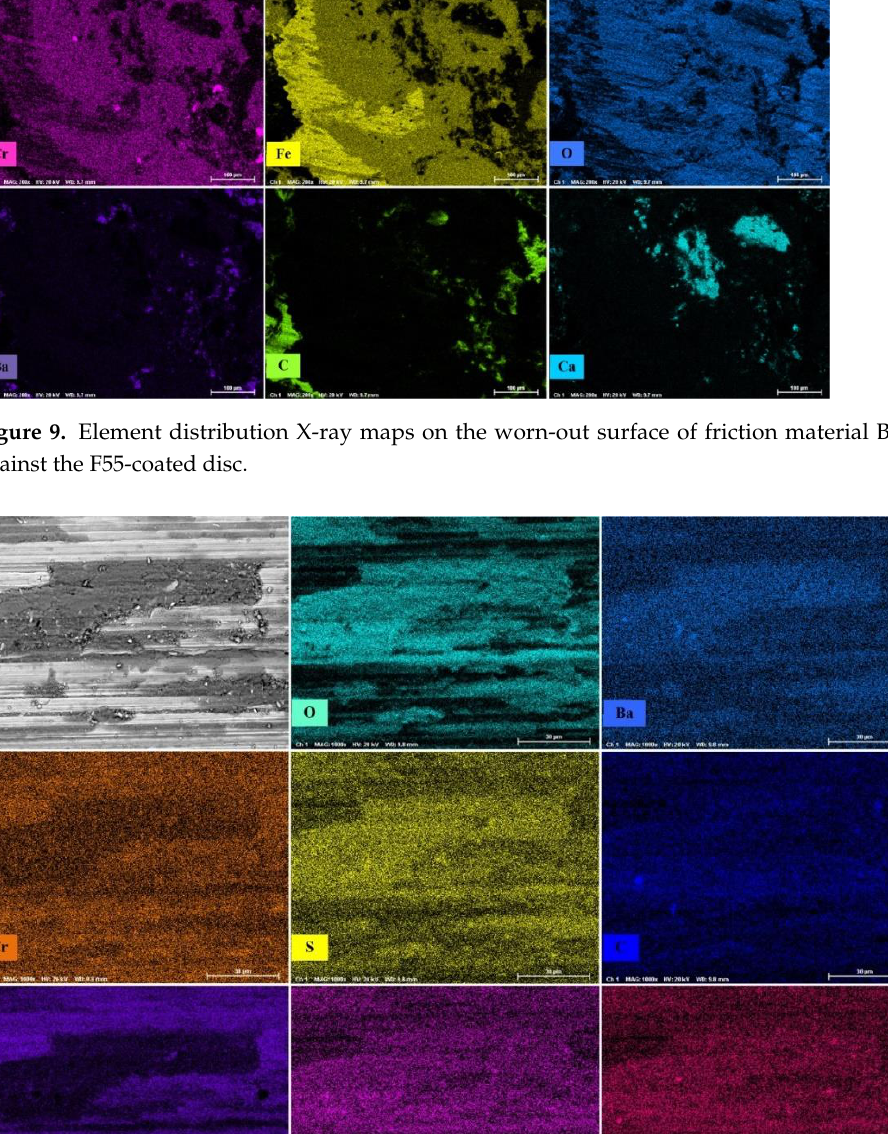
Figure 10. Element distribution X-ray map of the F55 + AISI415-coated disc surface after PoD testing against friction material B. Table 5. EDXS analysis of the highlighted area in Figure 8 (points 1, 2, 3, 4) .